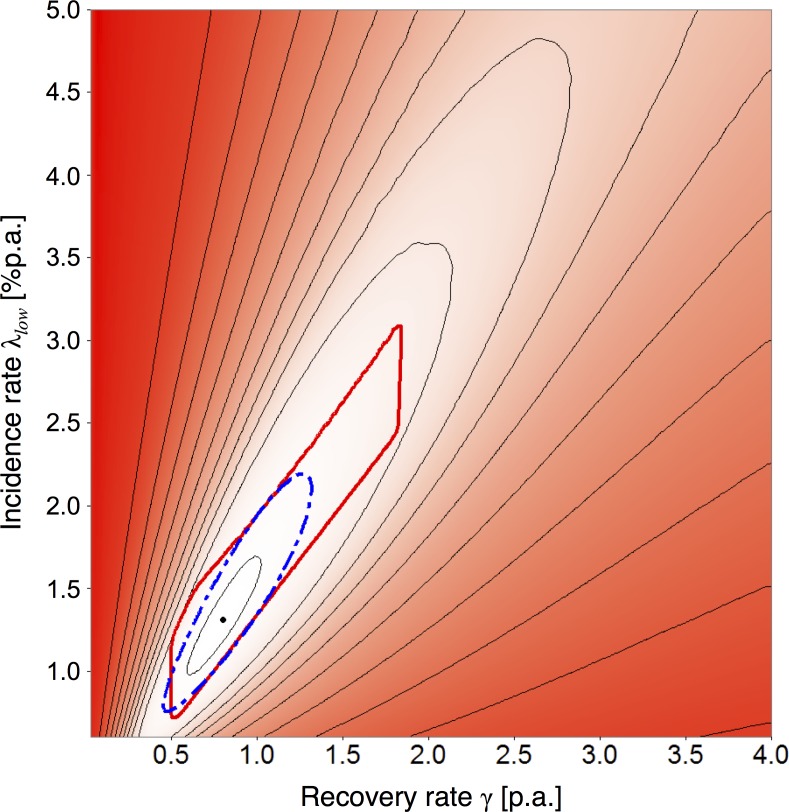
Recovery rate vs. incidence rate, maximum-likelihood estimate and plausible parameter range, London students.Black dot: maximum-likelihood estimate (MLE) for the recovery rate (γ = 0.80p.a.) and the incidence rate (λlow = 1.31%p.a.); the ratio λhigh/λlow was fixed at the MLE of 3.0; thin, black contours: equal likelihood; combined likelihood for all six data items (see Fig 4); colored areas: white indicates maximum likelihood, red indicates low likelihood; thick, dashed, blue contour: 95% CI of the MLE; thick, red contour: parameter area where the model is consistent with the empirical data (α<0.05).